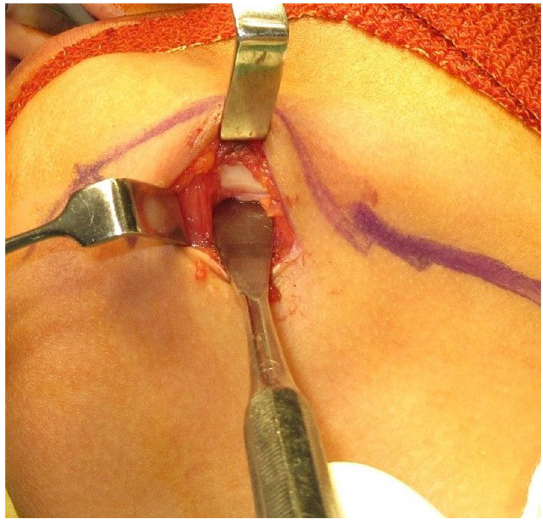
Fig. 2 Identification of platysmal attachment to mandible